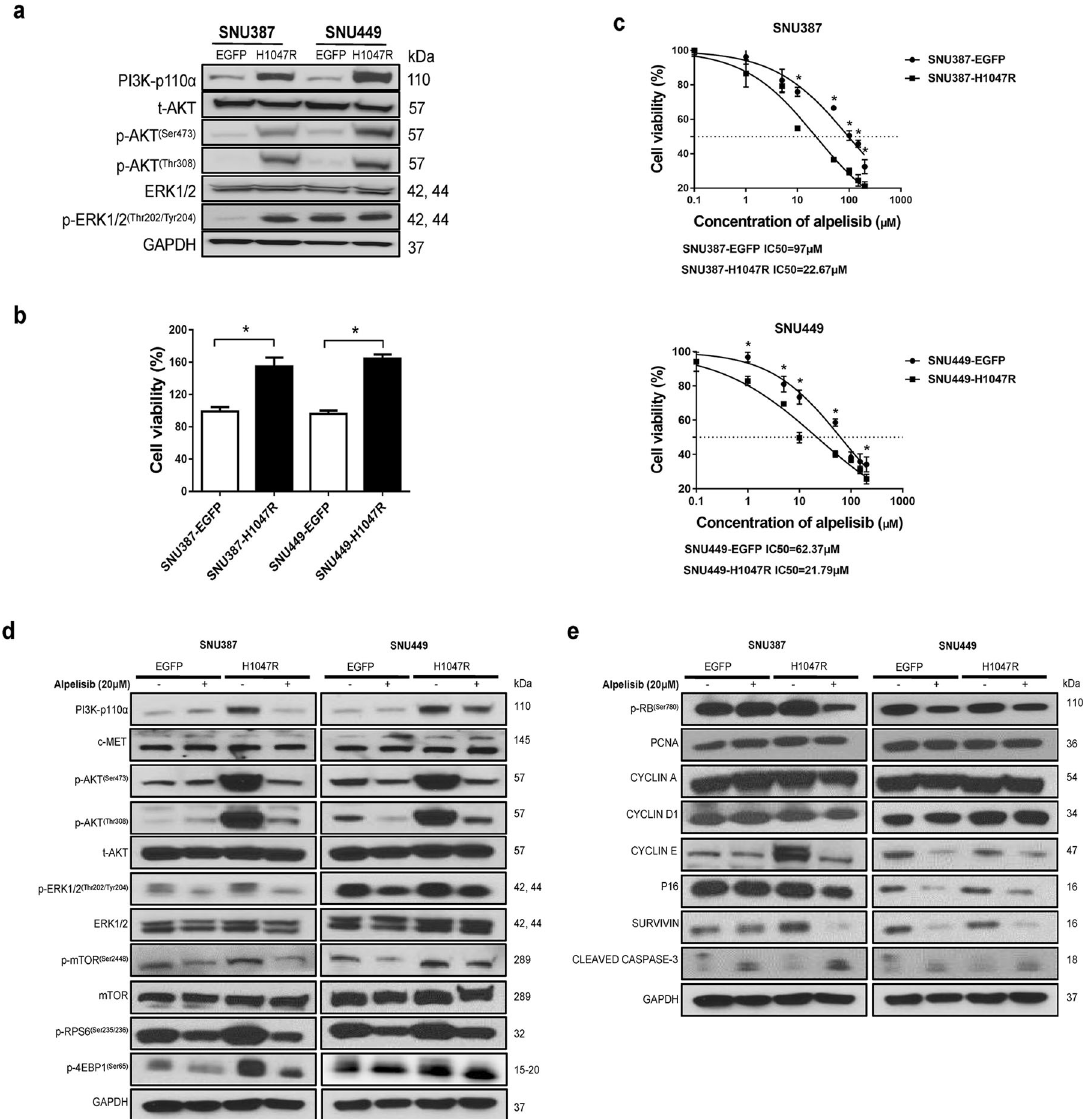
Fig. 1 Transfection of PIK3CAH1047R mutation increases the sensitivity to alpelisib treatment of HCC cells. a Transfection of PIK3CAH1047R mutation construct by lentivirus and activation of its downstream effectors in SNU387 and SNU449 cell lines was con fi rmed by western blot analysis. b Transfected cell lines were seeded in 24-well plates at 2.5 × 105 for 48 h, and cell viability was calculated. c Transfected cell lines were treated with escalating concentrations of alpelisib for 48 h, and IC50 values were calculated. d Western blot analysis of AKT/ mTOR and Ras/MAPK pathways after treatment with alpelisib. e Western blot analysis of cell-cycle-related proteins after treatment with alpelisib. Statistical signi fi cance of at least P < 0.05 is denoted by asterisk (Supplementary Fig. S19b and c). Immunostaining con fi rmed the deletion of PTEN and alpelisib treatment did not decrease tumor proliferation (Supplementary Fig. S20). Consistently, no signi fi cant downregulation of MAPK/ERK-, AKT/mTOR-, or cell proliferation- related proteins was detected (Supplementary Figs. S21 and S22). Thus, the data indicate that alpelisib has no therapeutic ef fi cacy against c-Met/sgPten murine HCC, supporting the speci fi city of alpelisib against PIK3CA -mutated HCC.